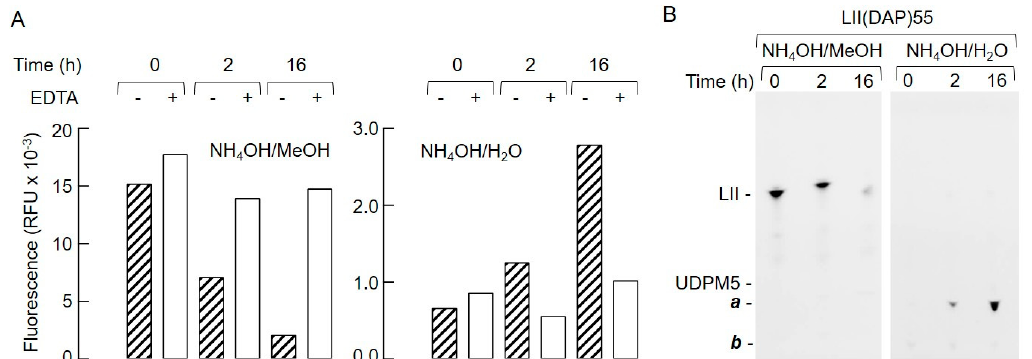
Figure 4. Hydrolysis of lipid II by rat liver microsomal proteins. ( A ) LII(DAP)55 (500 pmol) was incubated with detergent-solubilized rat liver microsomal proteins, as described in Section 4, for the indicated times in either the absence or presence of 10 mM ethylenediaminetetraacetic acid (EDTA). After solid-phase extraction (SPE) using Vm-beads as described for Figure 1, the fluorescence values associated with the fractions eluted with 15 mM NH 4 OH in methanol (left panel) and 15 mM NH 4 OH in H 2 O (right panel) were summed. ( B ) LII(DAP)55 (500 pmol) was incubated as described above for the indicated times in the absence of EDTA. After SPE using Vm-beads, the 15 mM NH 4 OH / methanol and 15 mM NH 4 OH / H 2 O eluates were dried down and analyzed by thin-layer chromatography (TLC) as described in Section 4. The migration positions of LII(DAP)55 (LII) and uridine diphospho MurNAc pentapetide (UDPM5) are shown. The components a and b are discussed in the text.